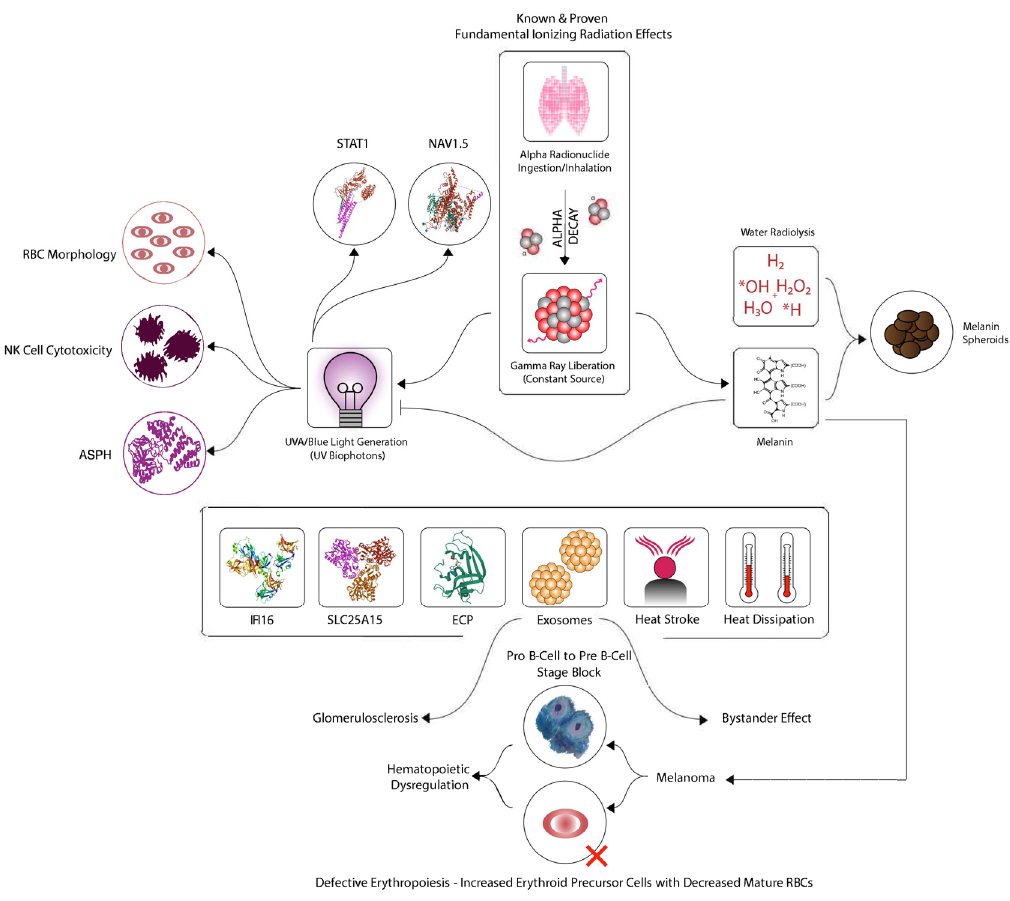
Figure 1. The proposed model: In this CFIDS model, internal radionuclide exposure generates gamma-rays to produce UVA biophotons. Various biomarkers are shown that are common to both CFIDS and melanoma. Hematopoietic dysregulation is a key characteristic in this process. The various steps in the model including the chemical (redox) reactions are described in the text.